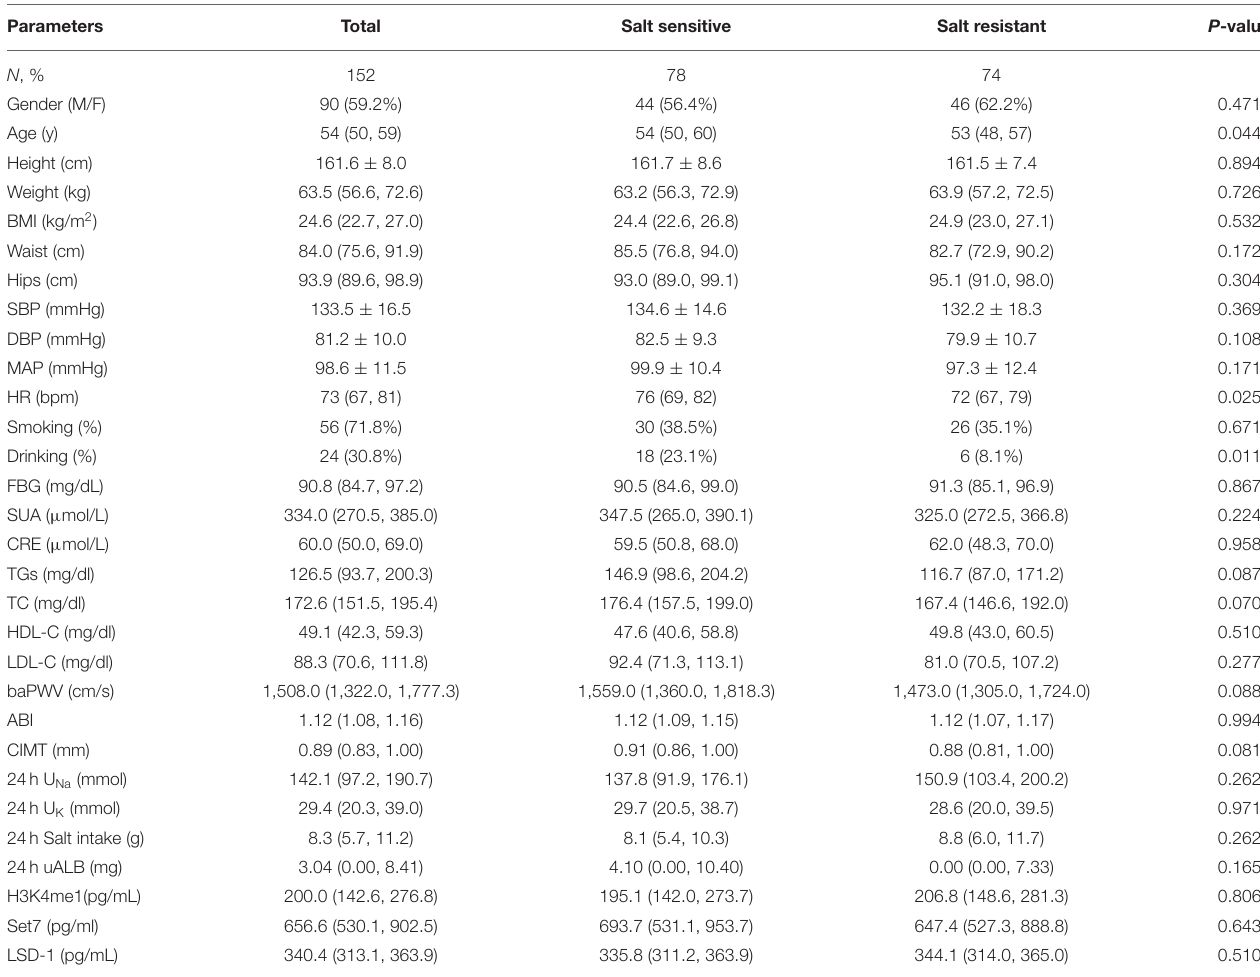
TABLE 1 | Baseline characteristics of participants by salt sensitivity.